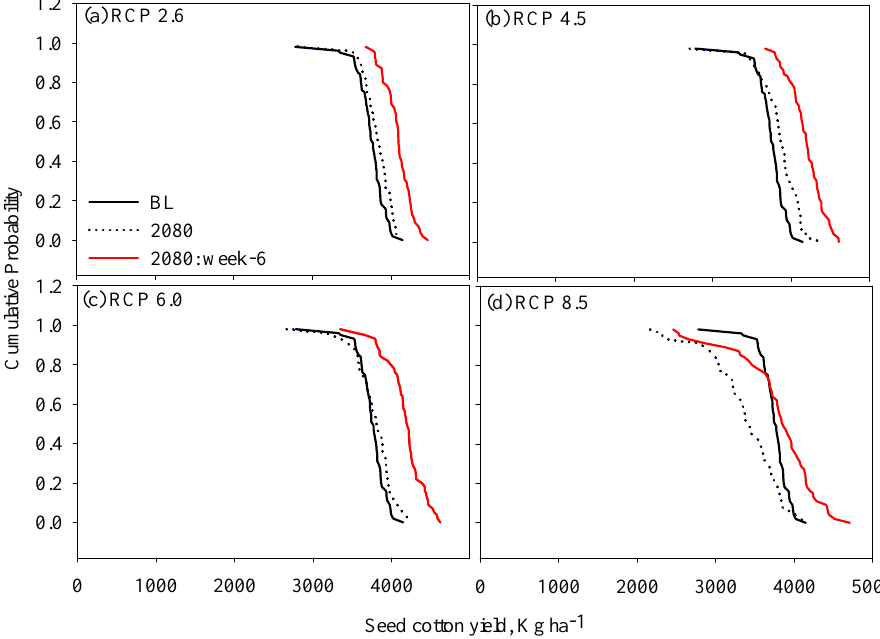
Figure 13. Comparison between the simulated irrigated seed cotton yield under baseline (BL) climate and climate change (CC; changes in CO 2 , temperature, and rainfall) in 2080 for RCP 2.6 ( a ), 4.5 ( b ), 6.0 ( c ), and 8.5 ( d ) for normal day of planting (2 May) and earlier than normal-day plantings of six weeks (week-6). In 2080, under rainfed conditions, planting six weeks before the normal planting date resulted in marginal yield rises of 6% each under CC scenarios in response to RCP 4.5 and 6.0 (Figure 14a–d).